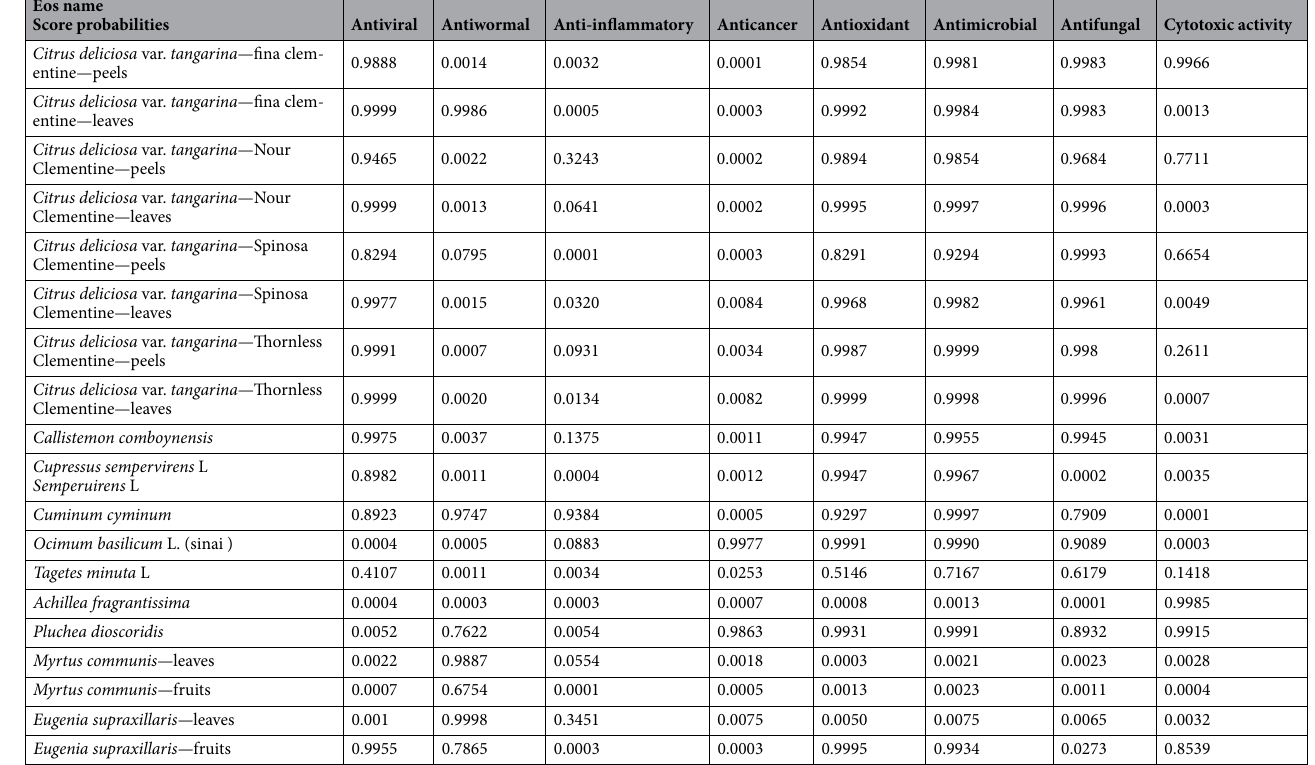
Table 5. A sample of the Score Probabilities for the CNN Training